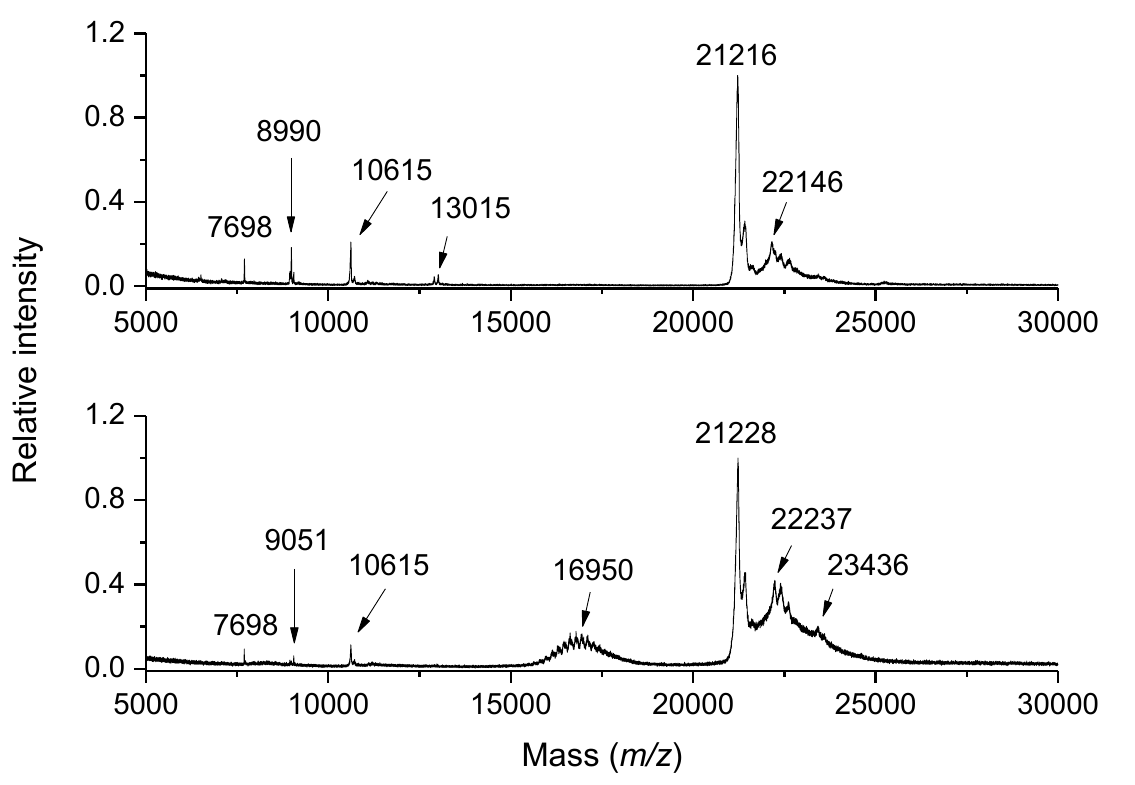
Figure 3. MALDI-TOF MS of white wine. All measurements were conducted using a Microflex LRF20 instrument (Bruker Daltonics), and the mass spectra were acquired in the reflector positive ion mode with an MSP BigAnchor 96 BC target and SA as a matrix (10 mg/mL in ACN:0.1% TFA, 1:1, v/v ). The top panel refers to a partially fermented grape juice (Federweisser) after dialysis against water, while the bottom panel spectrum comes from a dialyzed and ultrafiltered Sauvignon blanc wine. Each sample (1 µ L) was mixed with 1 µ L of the matrix solution on the target and left to dry and crystallize prior to the measurements. The content is author ´ s own